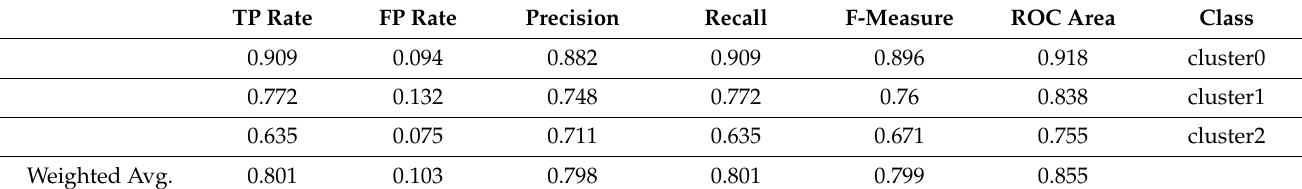
Table 7. Accuracy of the